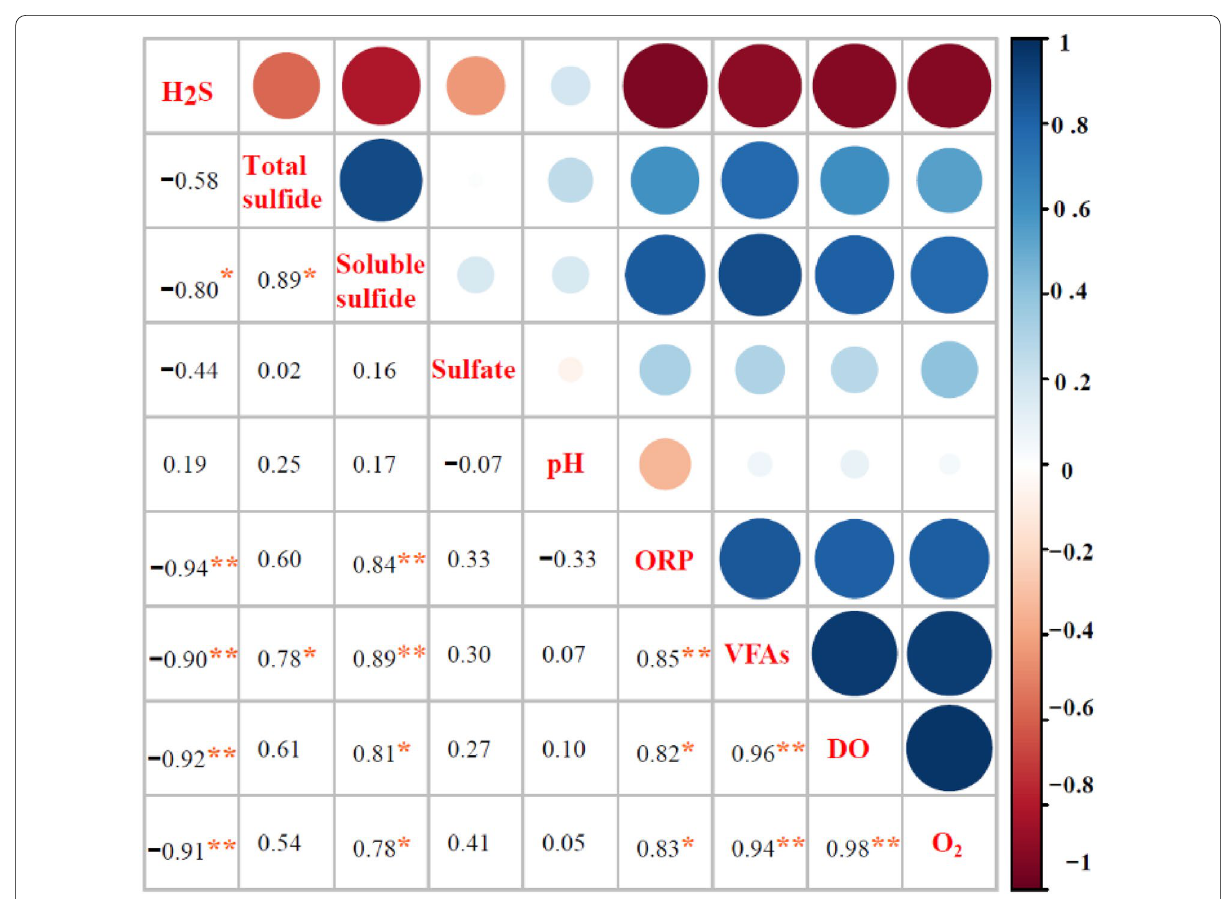
Fig. 4 Pearson correlation heatmap between physiochemical characteristics and H 2 S concentration. (Note Significance level: * P < 0.05, ** P < 0.01, n =